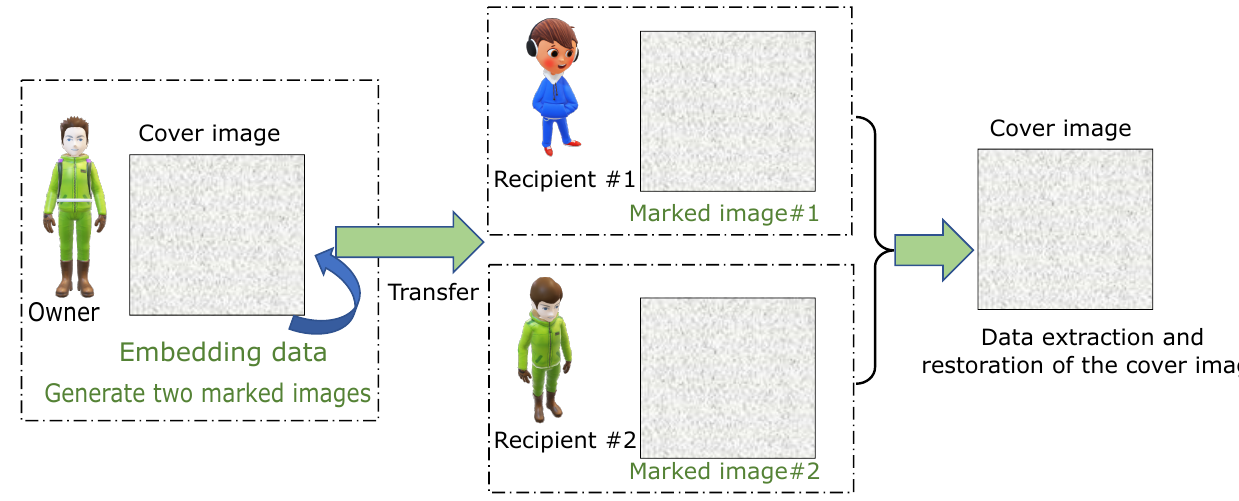
Figure 1. Schematic diagram of the dual-image RDH application